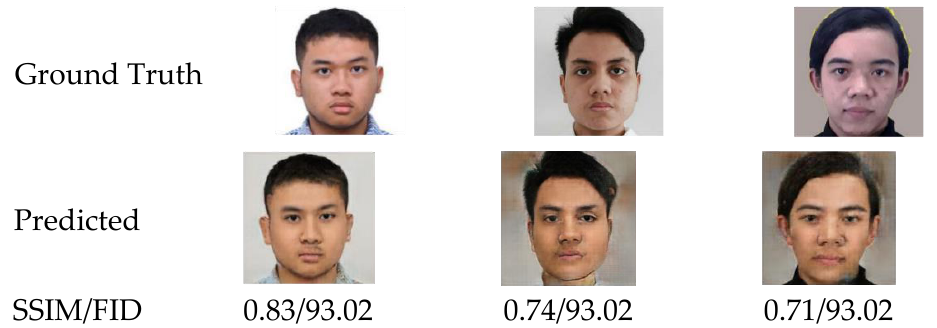
Figure 5. Results of cGAN-TV on the testing data.